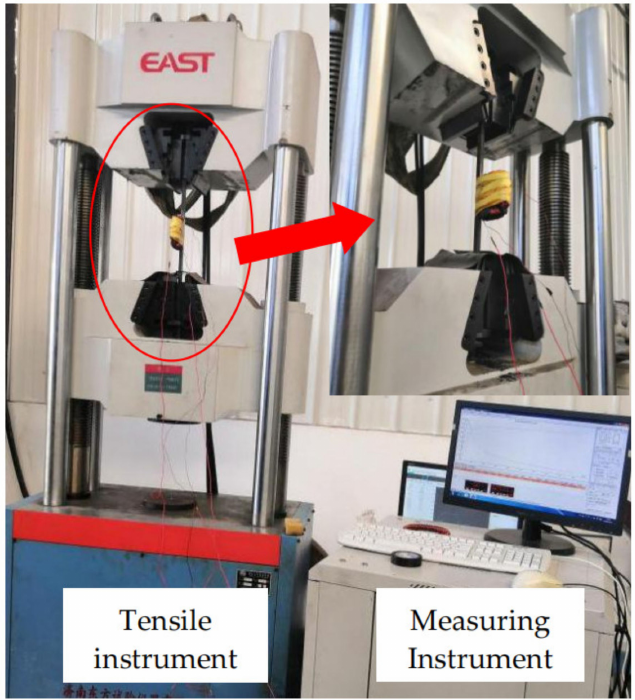
Figure 3. Magnetization curve measurement.